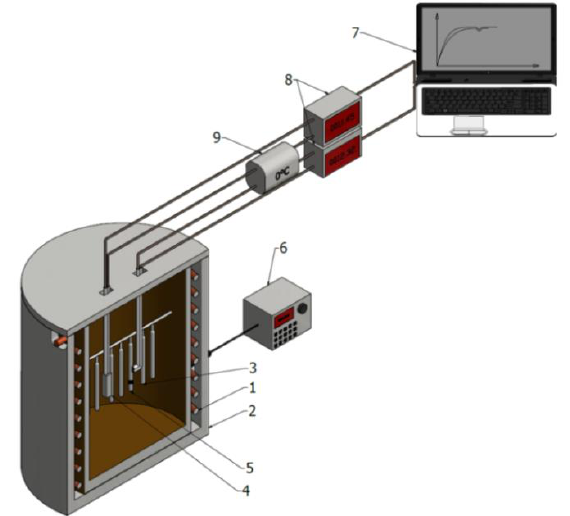
Figure 2. Scheme of the test stand: 1 — heating spiral of the furnace; 2 — external shield of the furnace; 3 — test pieces; 4 — thermocouple to measure temperature in the furnace; 5 — test piece with the thermocouple; 6 — control system of the furnace; 7 — computer storing the results; 8 — digital micro-voltmeter of V540, V544 type; 9 – thermos.